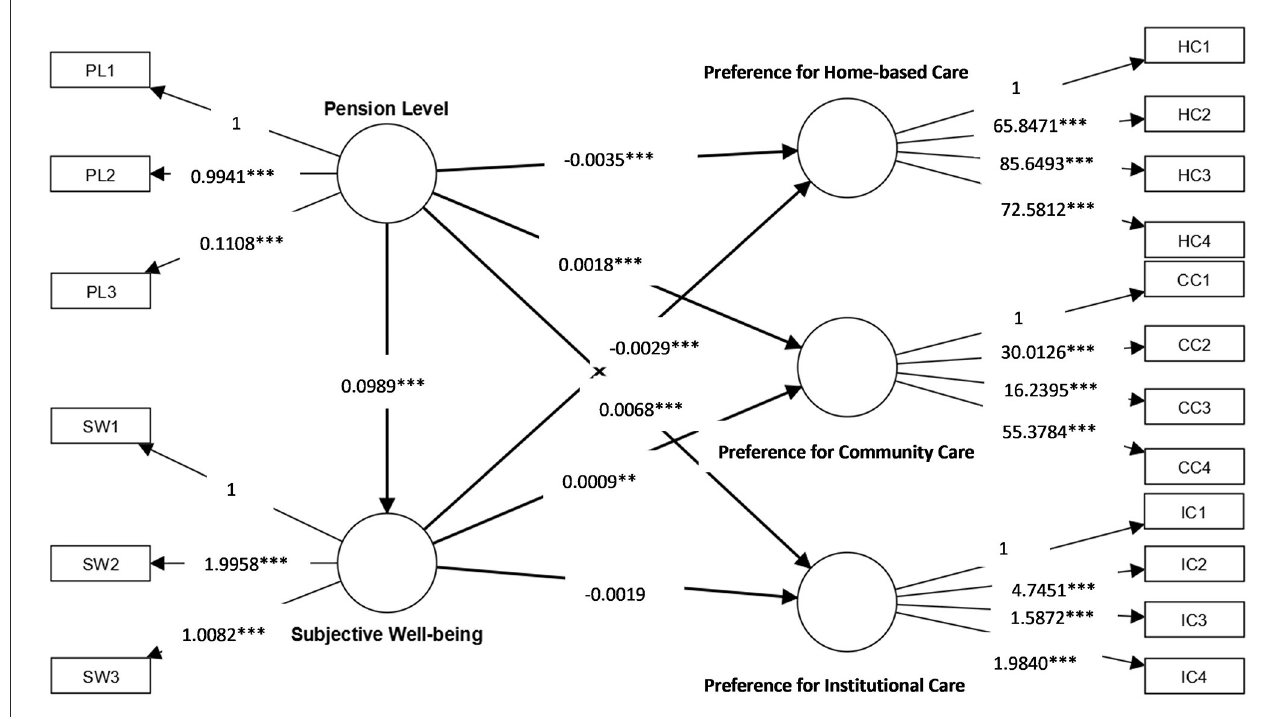
FIGURE2 Model results. *** , ** , and * indicate significance at the 1, 5, and 10% levels.